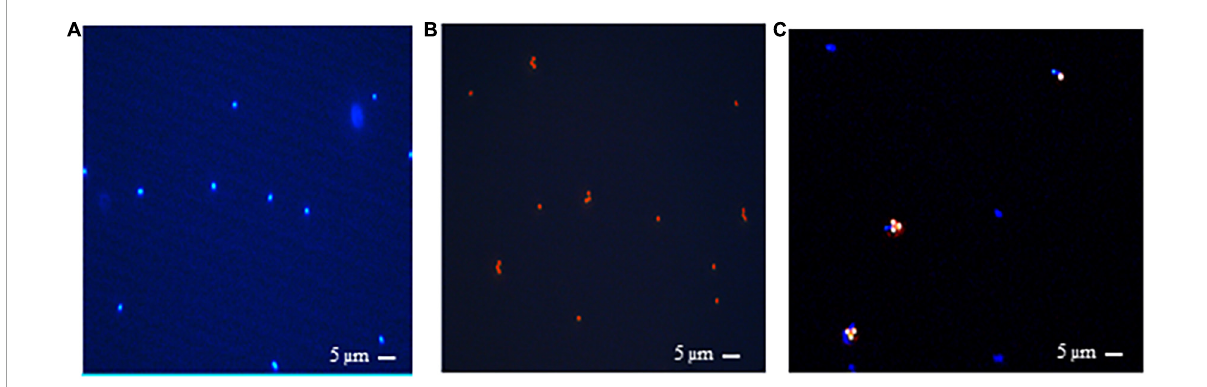
FIGURE2 Fluorescence microscopic images showing rumen methanogens which naturally fluorescence under UV light due to presence of coenzyme F 420 and emit a blue fluorescence with an excitation at 420 nm. (A) M. ruminantium strain M1, (B) 1- µ m beads viewed under UV illumination, (C) M. ruminantium M1 binding to M1-IMBs viewed under UV light. Methanogens with blue fluorescence are visible in complexes with beads under UV